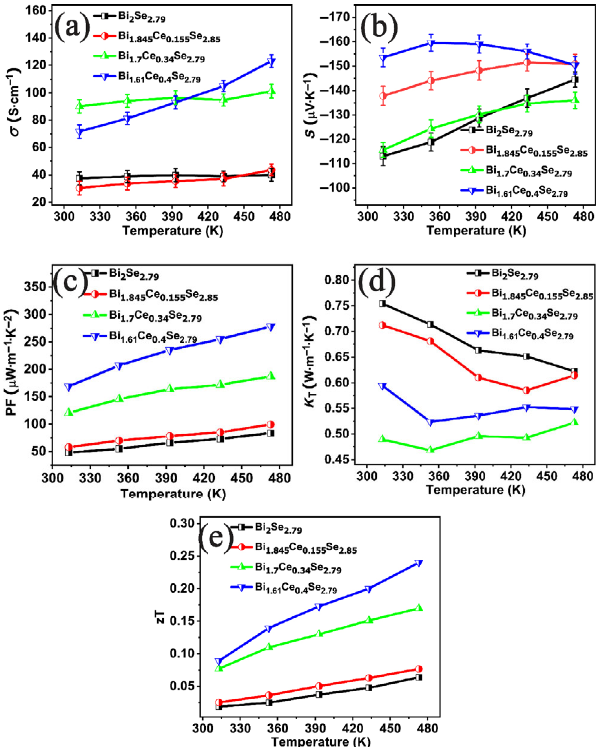
Figure 5 Temperature dependence of the (a) electrical conductivity (b) Seebeck coefficient (c) calculated power factor (d) the total thermal conductivity (e) the thermoelectric figure of merit of the Bi 2– x Ce x Se 3 samples. Adapted with permission from Ref. [100], © American Chemical Society